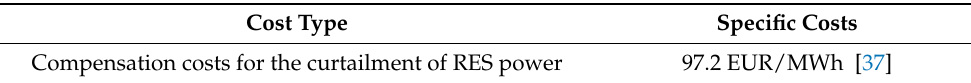
Table 9. Adopted specific costs for the curtailment of RES power.